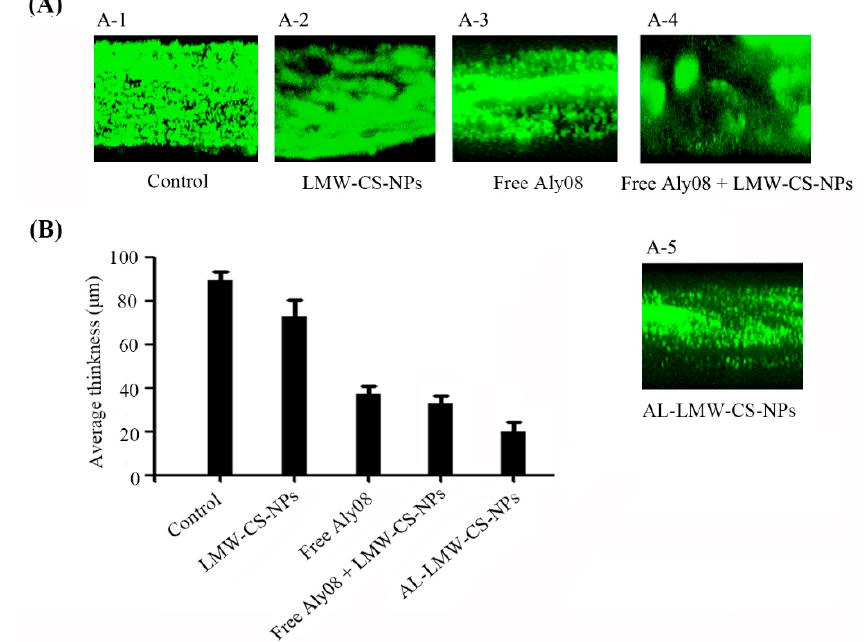
Figure 7. Biofilm disruptive activity in flow cell model. ( A ) CLSM analysis of P. aeruginosa PAO1 biofilm in flow cell with media supplemented without ( A-1 ) and with LMW-CS-NPs ( A-2 ), free Aly08 ( A-3 ), free Aly08 + LMW-CS-NPs ( A-4 ) and AL-LMW-CS-NPs ( A-5 ); ( B ) Average thickness of P. aeruginosa PAO1 biofilm.